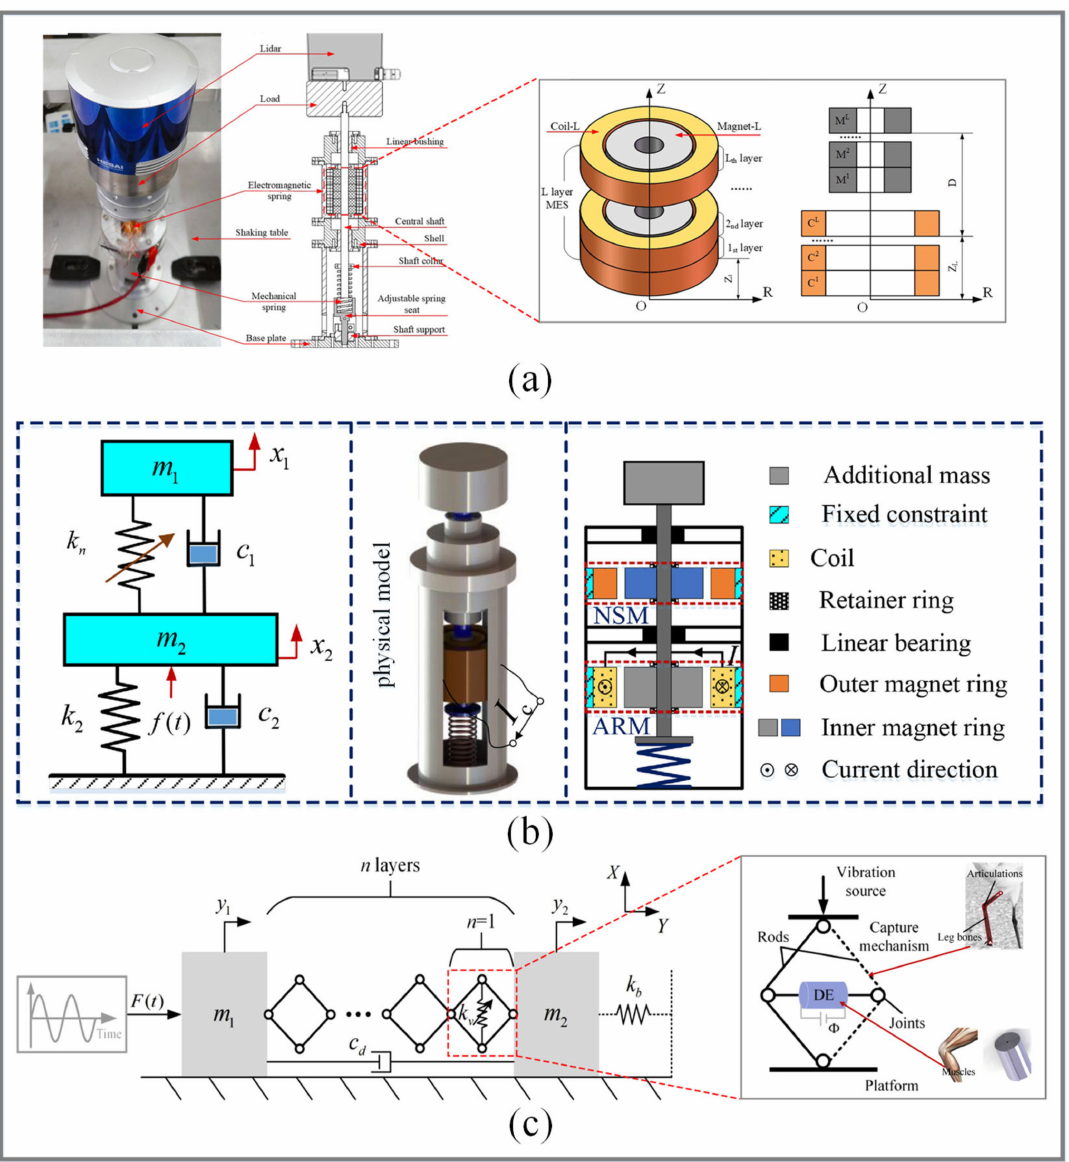
Figure 25. Active/semi-active QZS vibration isolation system with controller set in the system: ( a ) A novel compact and contactless multi-layer electromagnetic spring (MES) with tunable negative stiffness is proposed by Pu et al. [122]; Figures adapted with permission from Ref. [122]. Copyright 2019, copyright Pu, H.; ( b ) The semi-active electromagnetic QZS vibration isolator proposed by Chang et al. [134]; figures adapted with permission from Ref. [134]. Copyright 2022, copyright Chang, Y.; ( c ) The bio-inspired semi-active QZS vibration isolator with dielectric elastomer-based variable stiffness elements proposed by Zhao et al. [135]; figures adapted with permission from Ref. [135]. Copyright 2020, copyright Zhao,